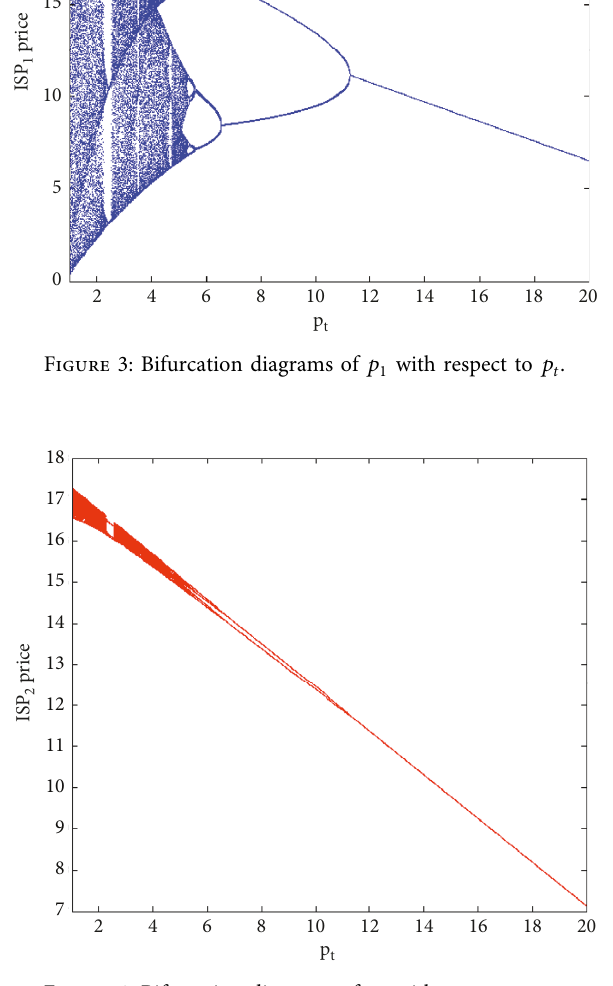
with respect to p t 2